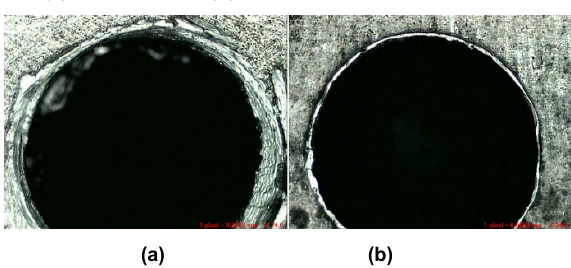
Figure 14. VMM images of holes “entrance” surface in CD for; (a) 1 %wtSiC and (b) 2 %wtSiC.